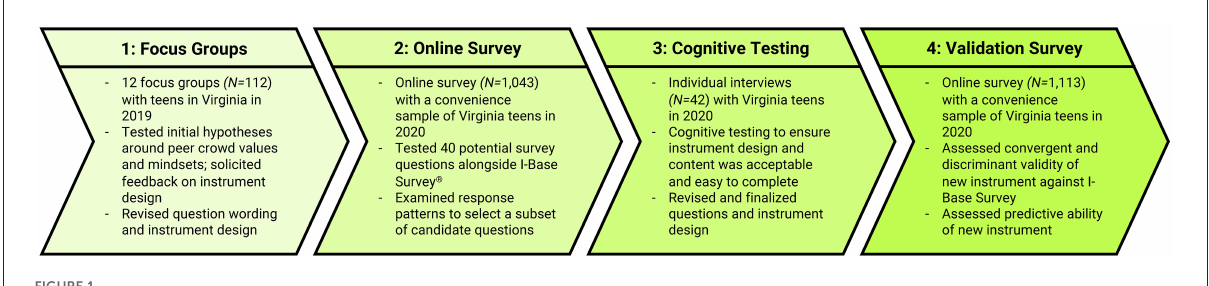
FIGURE1 Development of the Virginia’s Mindset Lens